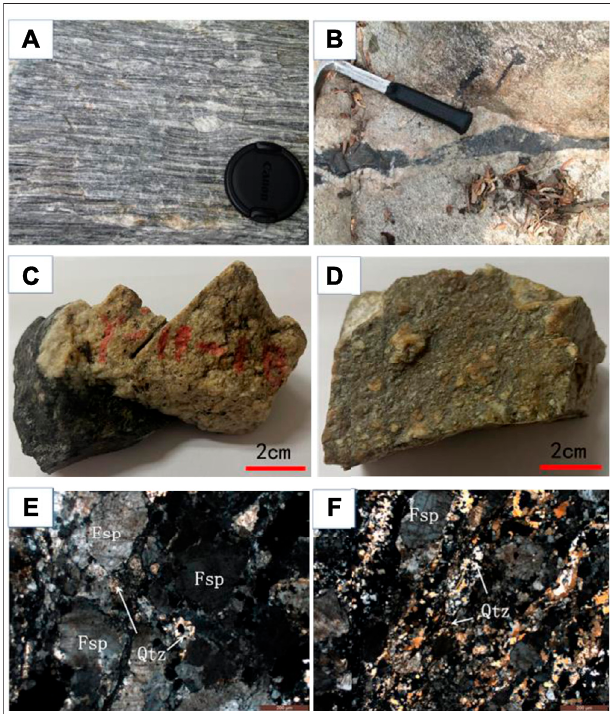
FIGURE 2 | Images of pseudotachylyte and cataclasite for hand specimen and microstructure under polarized light microscopy. (A) Mylonites develop foliation accompanied by augen-shaped structure (110827 – 2), (B) black vein of pseudotachylyte (Y11-1B), (C) hand specimen of pseudotachylyte (Y11-1B), (D) hand specimen of cataclasite (Y11-2B), and (E) and (F) microstructure of cataclasite under optical polarized light microscopy. (Qtz, quartz; Fsp, feldspar) (Y11-2B).